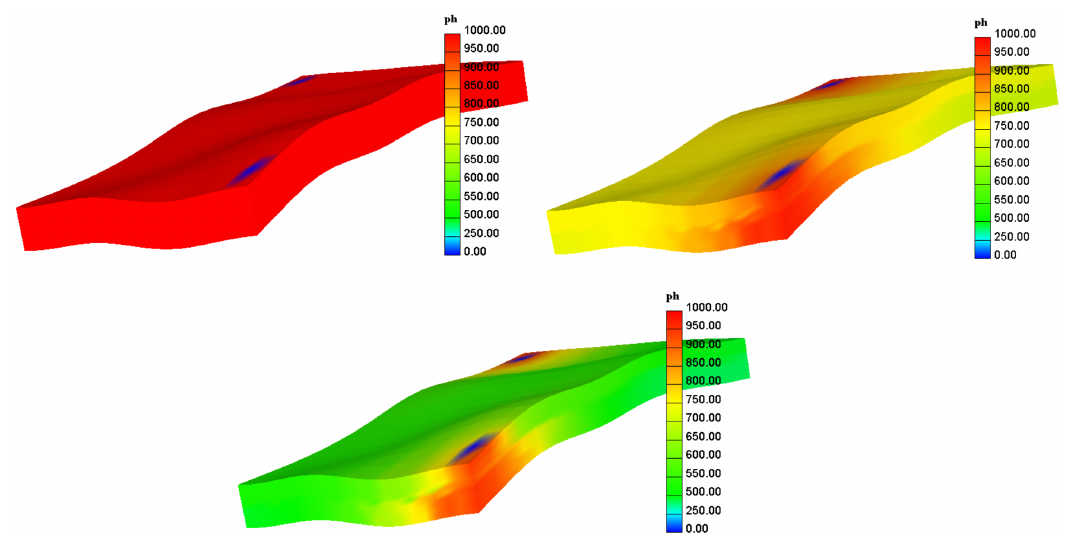
Figure 30. Pressure (Psi) snapshots at 0, 20, and 40